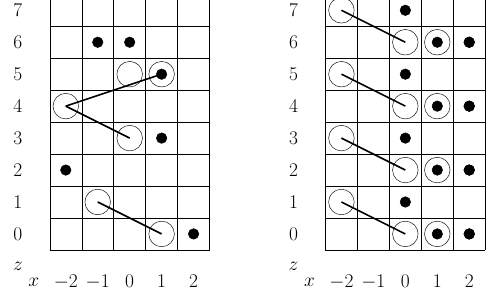
Figure 2: Example of parity patterns and θ -effect superimposed. A circle represents an odd column, a dot represents an affected column. The odd columns of a run are connected through a line. There are three runs in the first pattern: one of length 1 starting at (0 , 5), one of length 2 starting at (1 , 0) and one of length 3 starting at (0 , 3). Note that (1 , 5) is an odd column belonging to the run of length 3 and affected by the run of length 1. The second is an example of a symmetric parity pattern with period